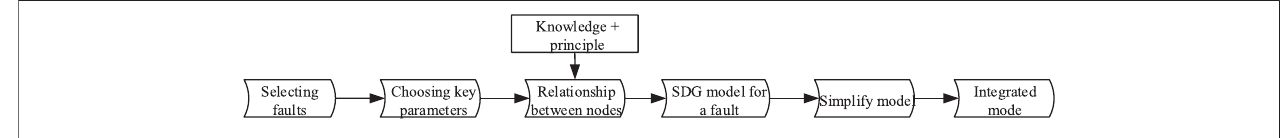
FIGURE 7 | Flow chart of SDG modeling.